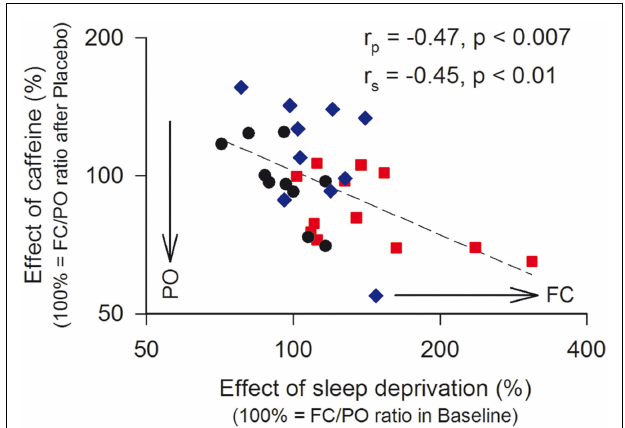
FIGURE 3 | Relationship between the effects of sleep deprivation and caffeine on FC/PO power ratios in the 6.25- to 8.25-Hz band of the waking EEG. To quantify the effect of sleep deprivation, the FC/PO ratio after sleep deprivation in the placebo condition was expressed as a percentage of the corresponding baseline value.To quantify the effect of caffeine, the FC/PO ratio after sleep deprivation in the caffeine condition was expressed as a percentage of the corresponding value in the placebo condition.Values above 100% indicate a shift of power in anterior direction (toward FC), whereas values below 100% indicate a shift of power in posterior direction (toward PO). Data are plotted on a double-logarithmic scale. Black dots: aged individuals; blue diamonds: caffeine-insensitive individuals; red squares: caffeine-sensitive individuals. A regression line was fitted through 32 individual data points. r p : Pearson’s product-moment correlation coefficient, r s : Spearman rank correlation